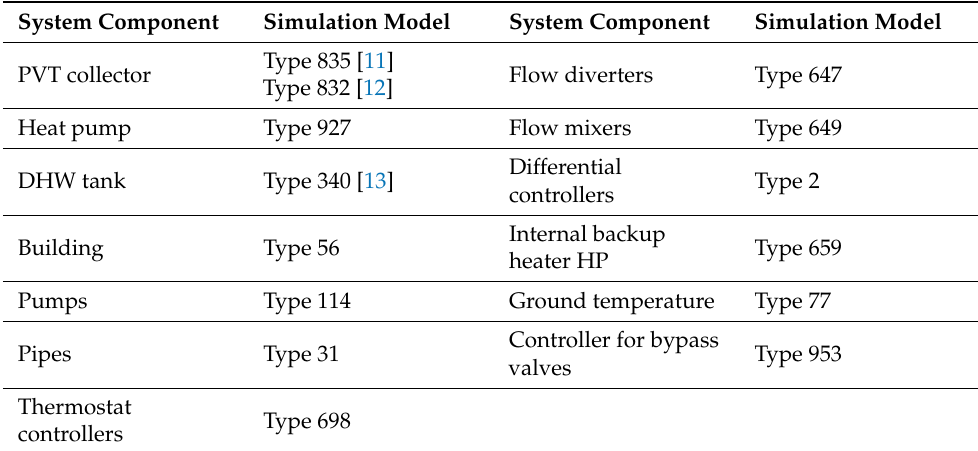
Table 1. Simulation models of the main system